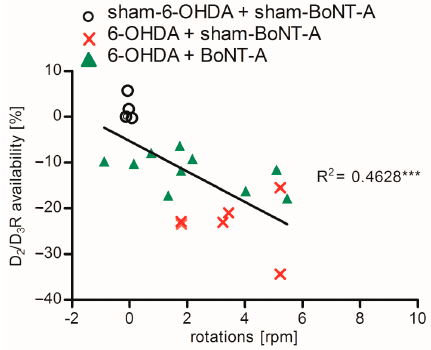
Figure 5. Linear correlation of right–left differences of D 2 /D 3 R availability in (%) and apomorphine-induced rotations one month after BoNT-A or sham-BoNT-A injection for controls (sham-6-OHDA + sham-BoNT-A), sham-injected hemi-PD rats (6-OHDA + sham-BoNT-A) and BoNT-A-injected hemi-PD rats (6-OHDA + BoNT-A). Controls did neither demonstrate interhemispheric differences nor rotational behavior. With increasing right–left differences also asymmetric rotations increased in hemi-PD rats and both was normalized after BoNT-A injection. Significance is displayed as *** p < 0.001.